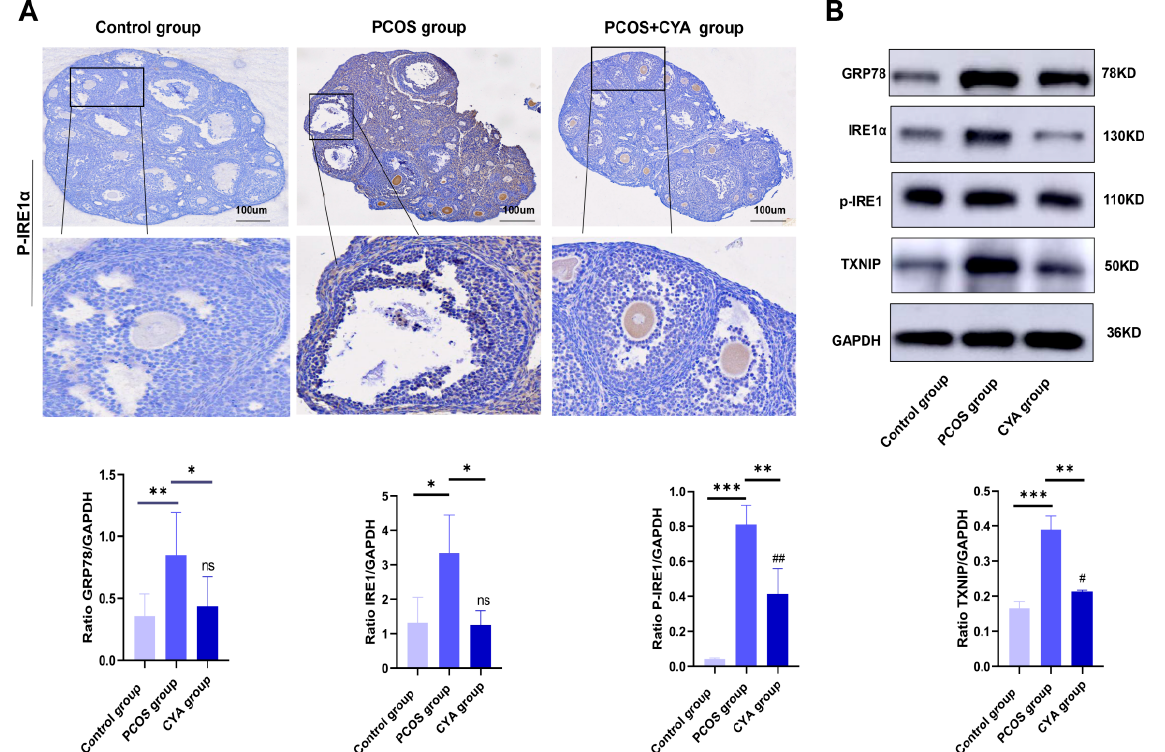
Figure 4. CYA effectively alleviates IRE1 signaling pathway activation induced by hyperandrogen in PCOS mice. ( a ) The expression of p-IRE1 α in ovaries was assessed with immunohistochemical tests; ( b ) the expressions of IRE1 α signaling pathway proteins were assessed with Western blot. Two independent experiments were performed with similar results. Data are shown as mean ± SEM. “*” represents comparison between groups, “#” indicates the treatment group compared to the control group,“ns” indicated that there was no statistical difference between the treatment group and the control group. * /# p < 0.05, **/## p < 0.01,*** /### p < 0.001.